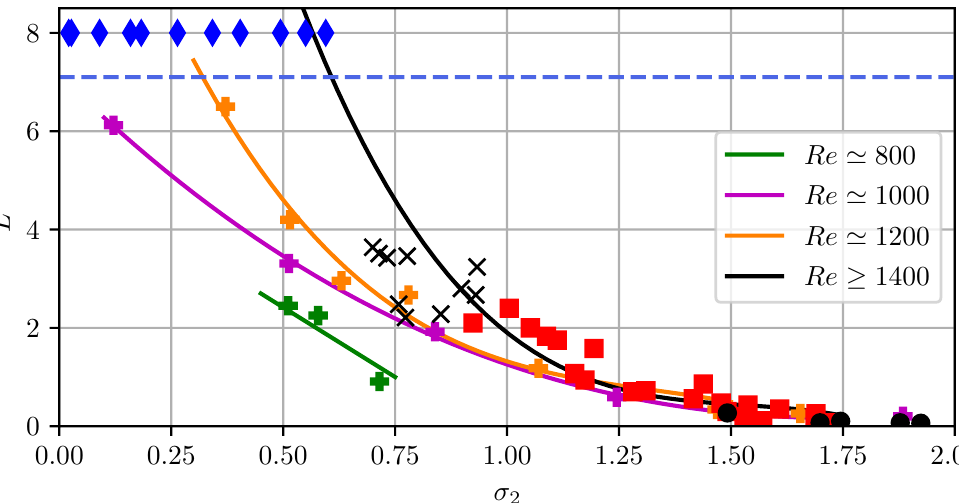
Figure 10. Dimensionless average length of the attached cavity L ∗ as a function of the outlet cavitation number σ 2 . For Re (cid:62) 1300, the symbols refer to the regimes identified in Figure 6: type-1 steady